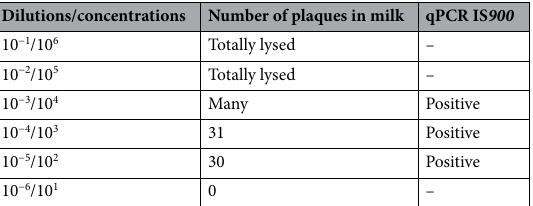
Table 2. Optimization of PMS-phage assay on MAP-spiked milk samples represented by the number of lysed plaques developed on MB 7H10 agar and the positivity status of DNA extracted from lysed plaques via qPCR IS 900 analysis.